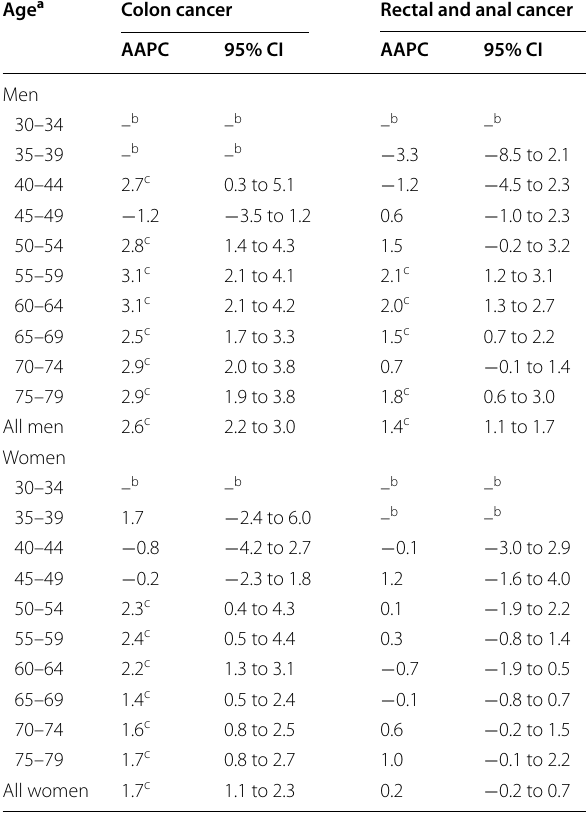
Table 5 Joinpoint regression analysis of age-specific mor- tality rates of colorectal cancer in Serbia, by sex, in the period